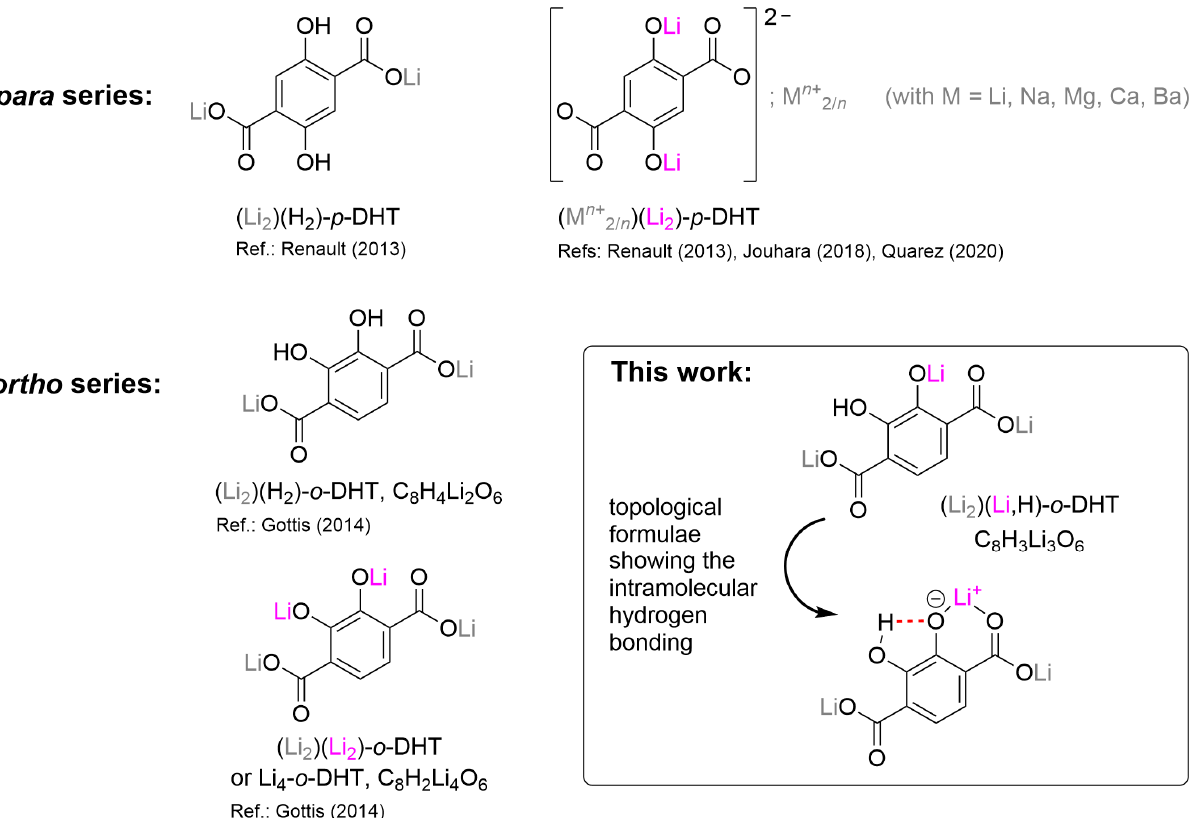
Figure 1. Topological chemical formulae of previously synthesized dihydroxyterephthalate (DHT) derivatives by our group together with the new compound reported in this article. Note that Li + cations potentially involved in a cathodic process are in pink.